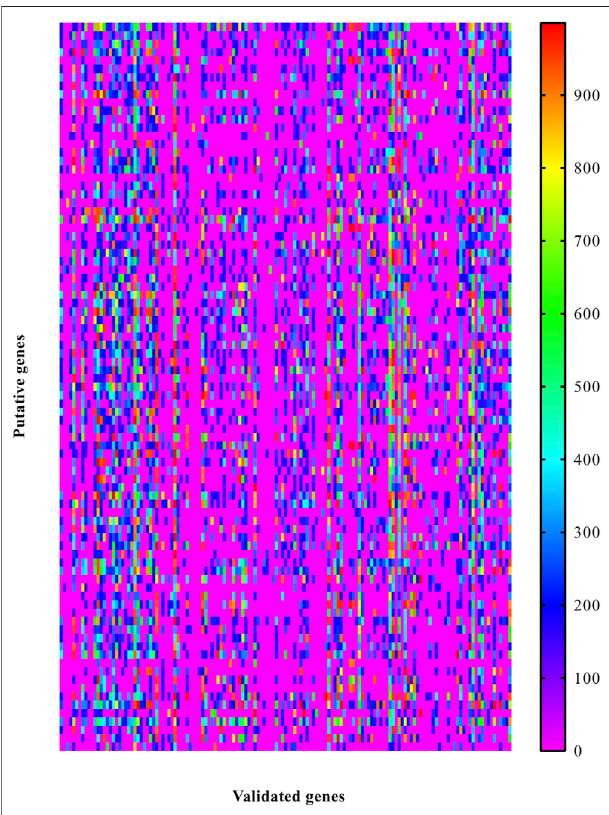
FIGURE 3 | Heat map to illustrate the associations between putative genes and validated ones associated with otitis media. Row represents putative genes and column indicates validated